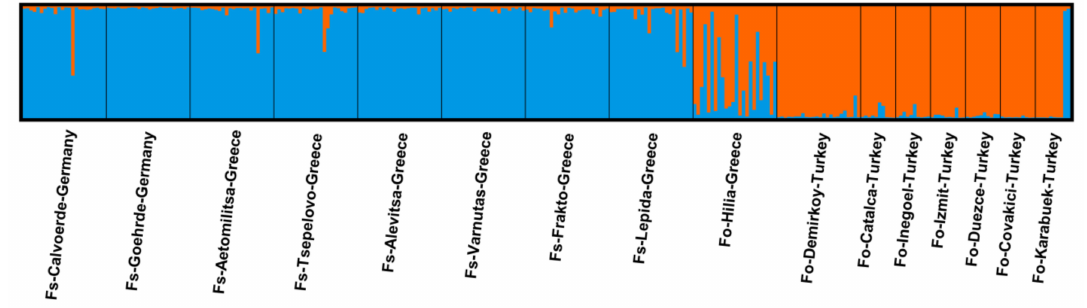
Figure 4. Clustering of individuals for K =